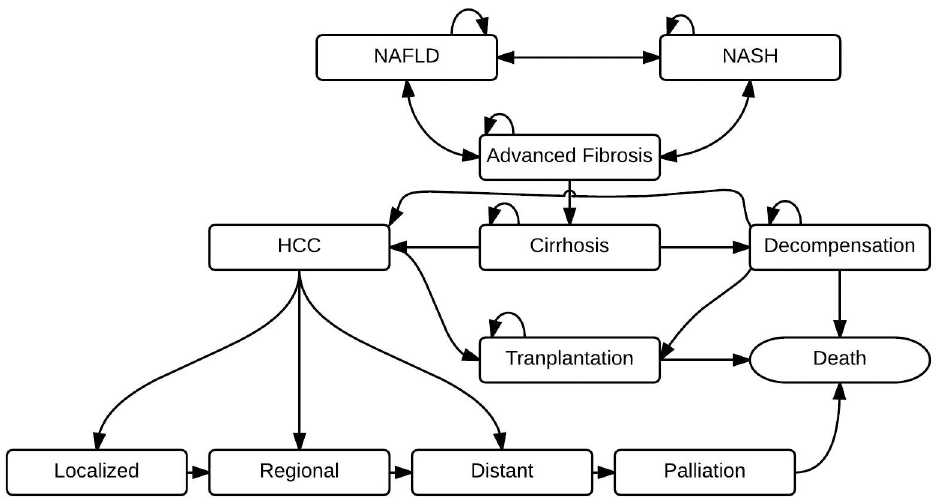
Fig 2. A Simplified Depiction of the Microsimulation State-Transition Model. HCC = Hepatocellular carcinoma; NAFLD = Nonalcoholic Fatty Liver Disease; NASH = Nonalcoholic Steatohepatitis.